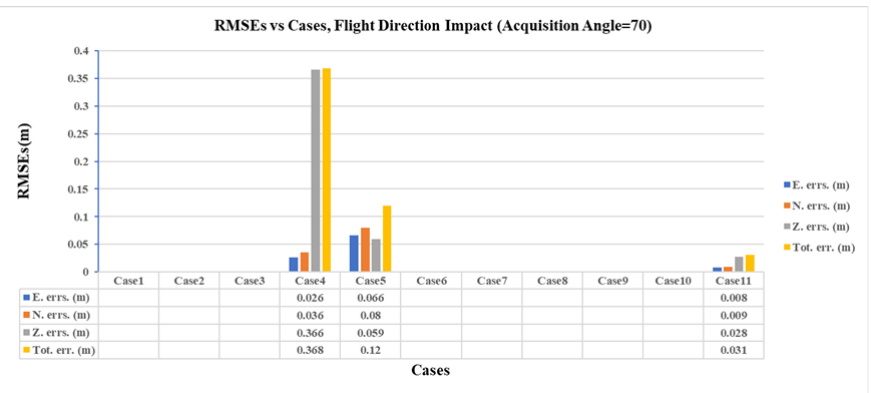
Figure 10. The impact of flight direction (acquisition angle = 70°).